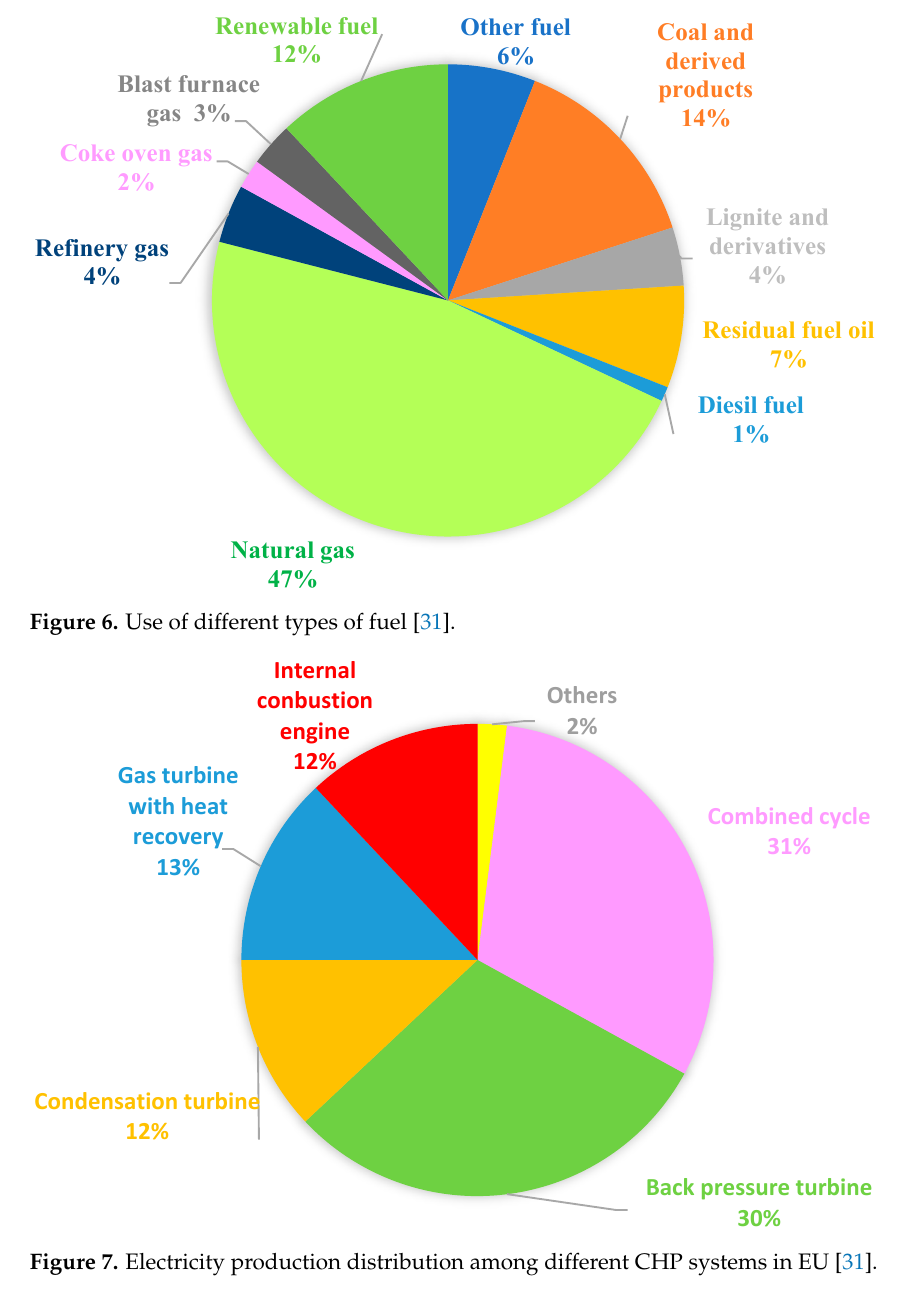
Figure 7. Electricity production distribution among different CHP systems in EU [31]. 3.9. Considerations Regarding Efficiencies 3.9.1. First Law Efficiency of CHHP The first law of efficiency of CHHP was introduced differently, since its expression depends on the priority of the useful effect given to (i) work or (ii) heat (particularly heat